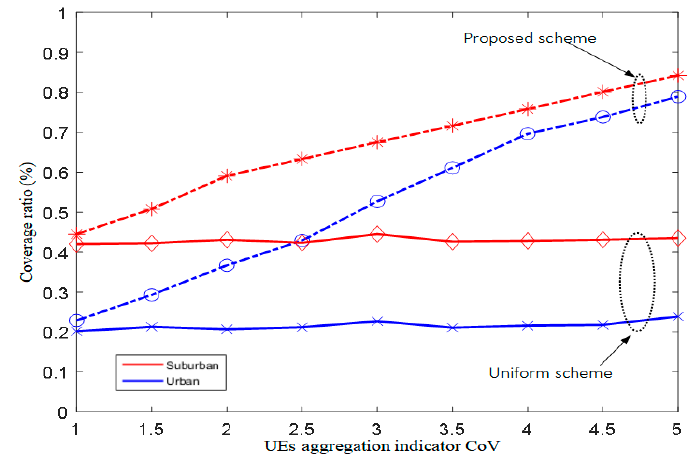
Figure 6. Coverage ratio of covered UE vs. coefficient of variation (CoV).